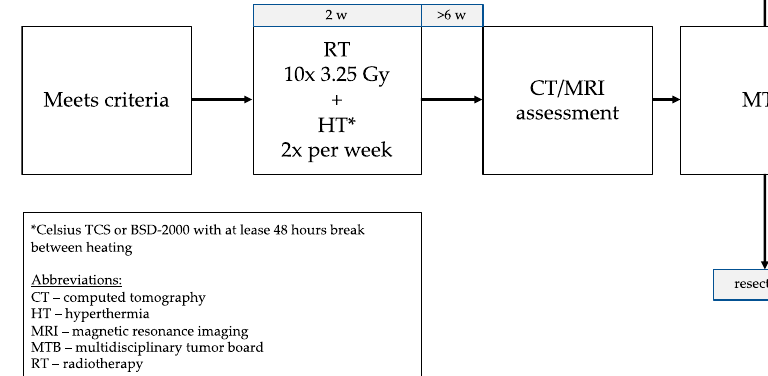
Figure 1. Treatment schedule.